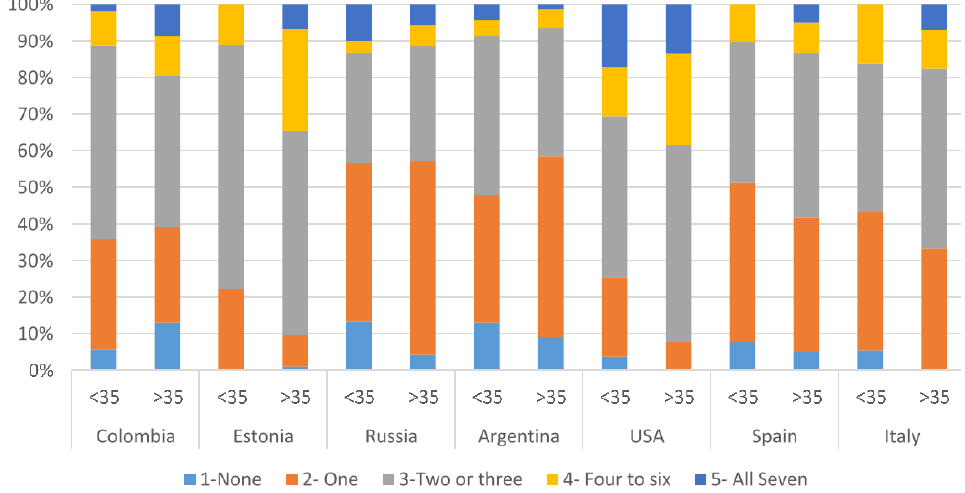
Figure 2. If someone were to look in your refrigerator each day for a week, on how many of the seven days do you think they would find leftover food in your refrigerator? Results presented for respondents aged <35 and ≥35 in each country, by percentage.